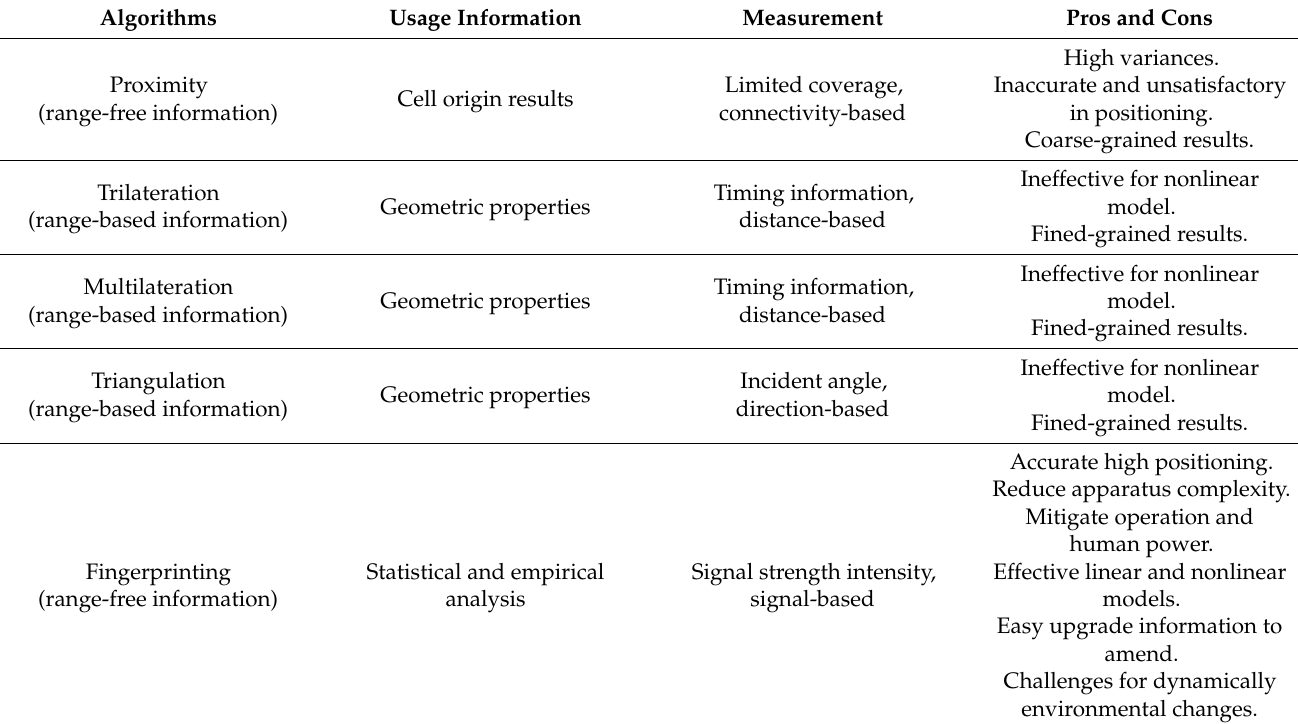
Table 3. The summary of the indoor positioning algorithm.